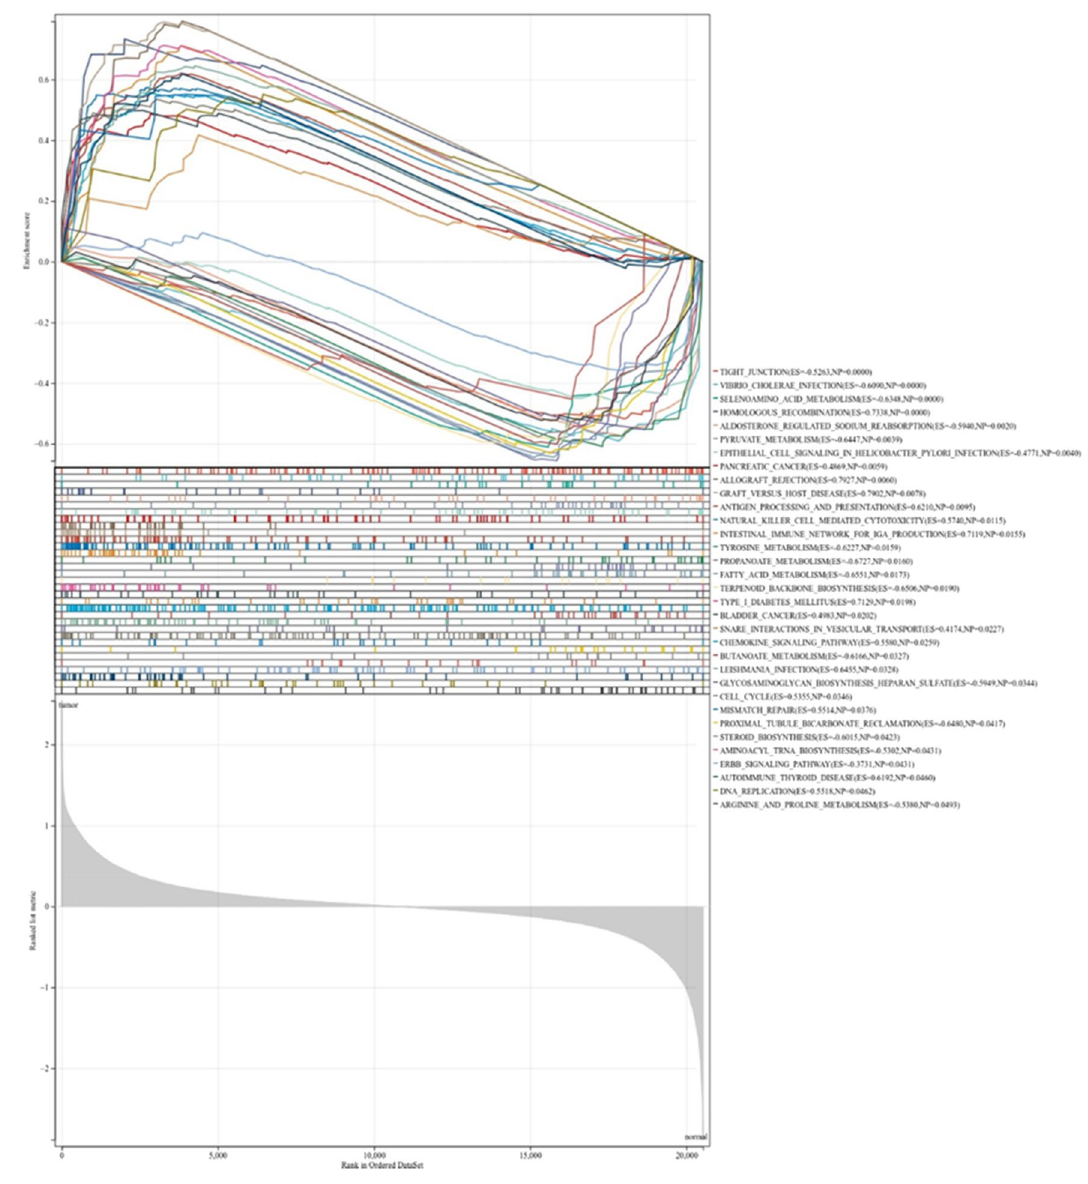
Figure 4. Gene set enrichment